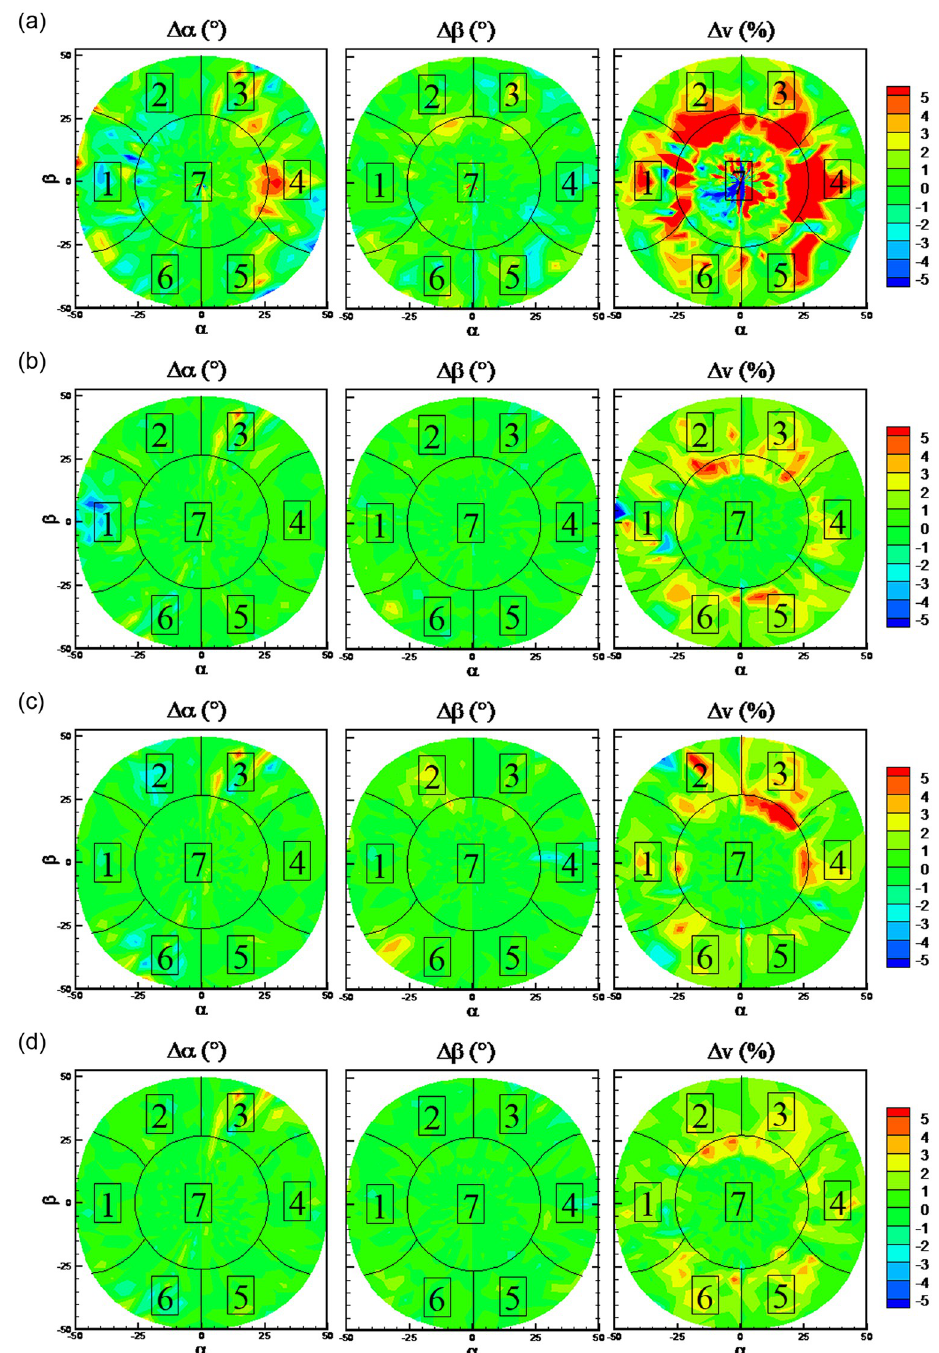
Fig 28. Error distributions with RFs algorithm. a) port 7 is invalid, b) port 1 is invalid, c) port 2 is invalid, d) normal case: all ports are